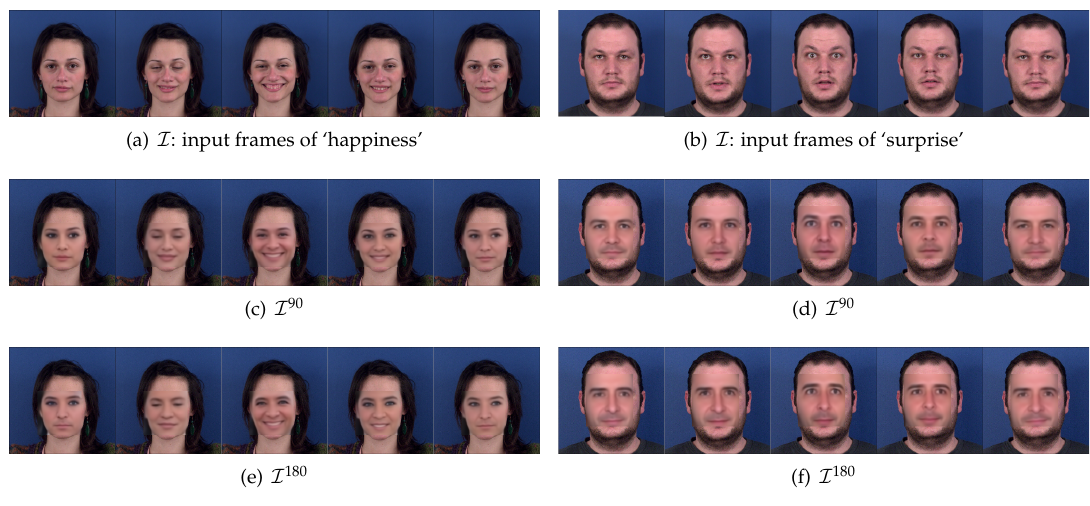
Figure 10. Results from the MUG dataset [61]: ( a,b ) results of original images, ( c,d ) results of de-identification images by rotating 90 degrees, ( e,f ) results of de-identification images by rotating 180